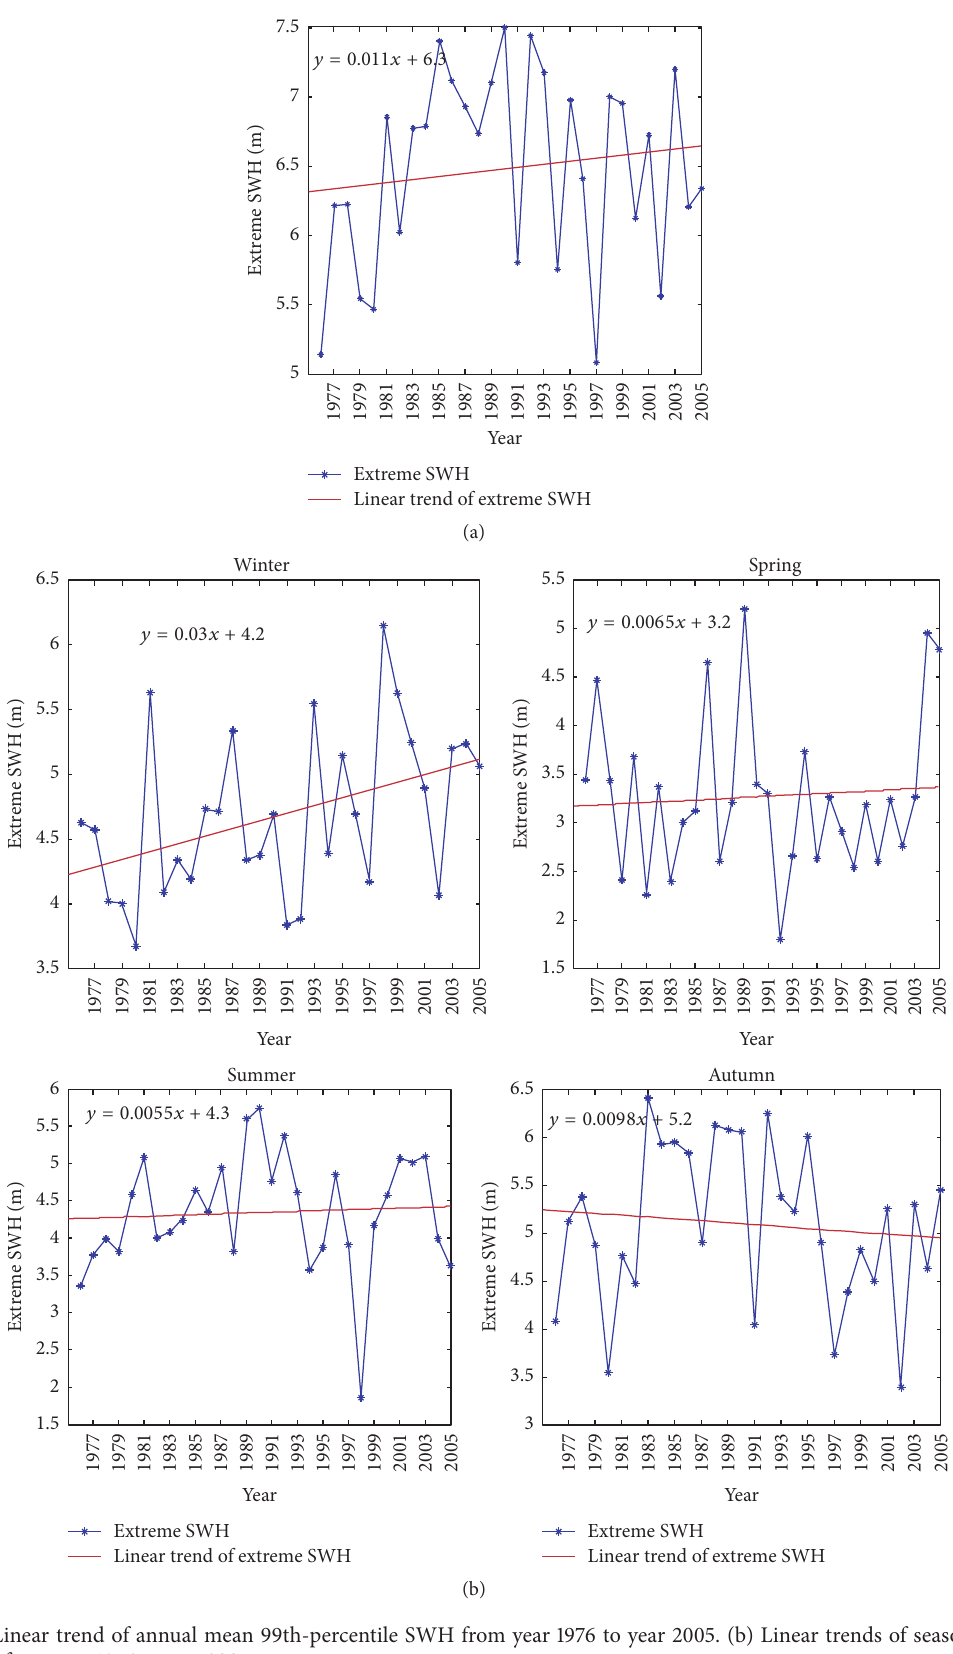
Figure 10: (a) Linear trend of annual mean 99th-percentile SWH from year 1976 to year 2005. (b) Linear trends of seasonal mean 99th- percentile SWH from year 1976 to year